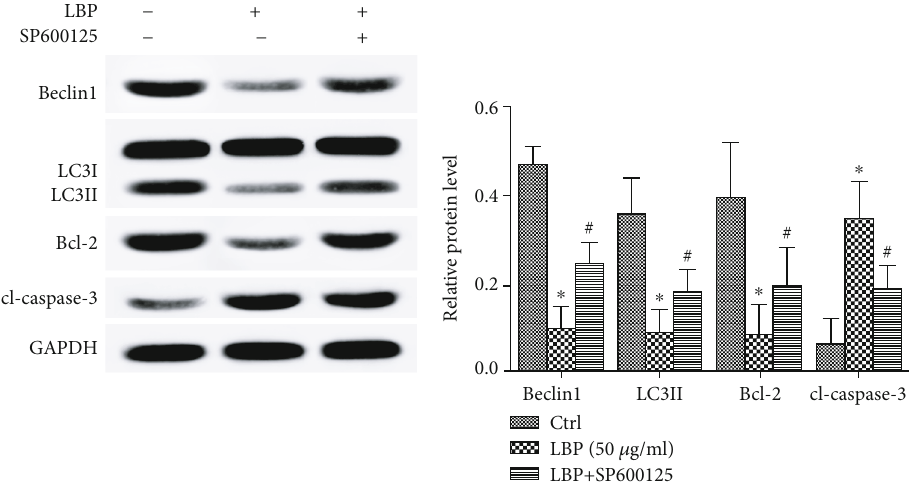
Figure 5: LBP induced apoptosis and inhibited autophagy in A431 cells. Compared with the control group, ∗ P < 0 : 01 ; compared with the LBP (50 μ g/ml) group, # P < 0 : 01 .